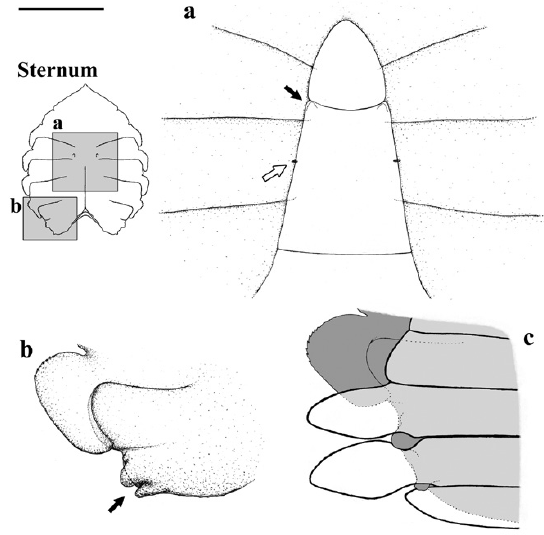
Figure 10 - Callinectes danae , 4 th stage of the juvenile phase: A , white arrow, the rudimentary female gonopores; black arrow, anterior “closing mechanism” position; B , posterior “closing mechanism” position, pointed by the arrow; C , schematic drawing of the position of the abdomen over the posterior “closing